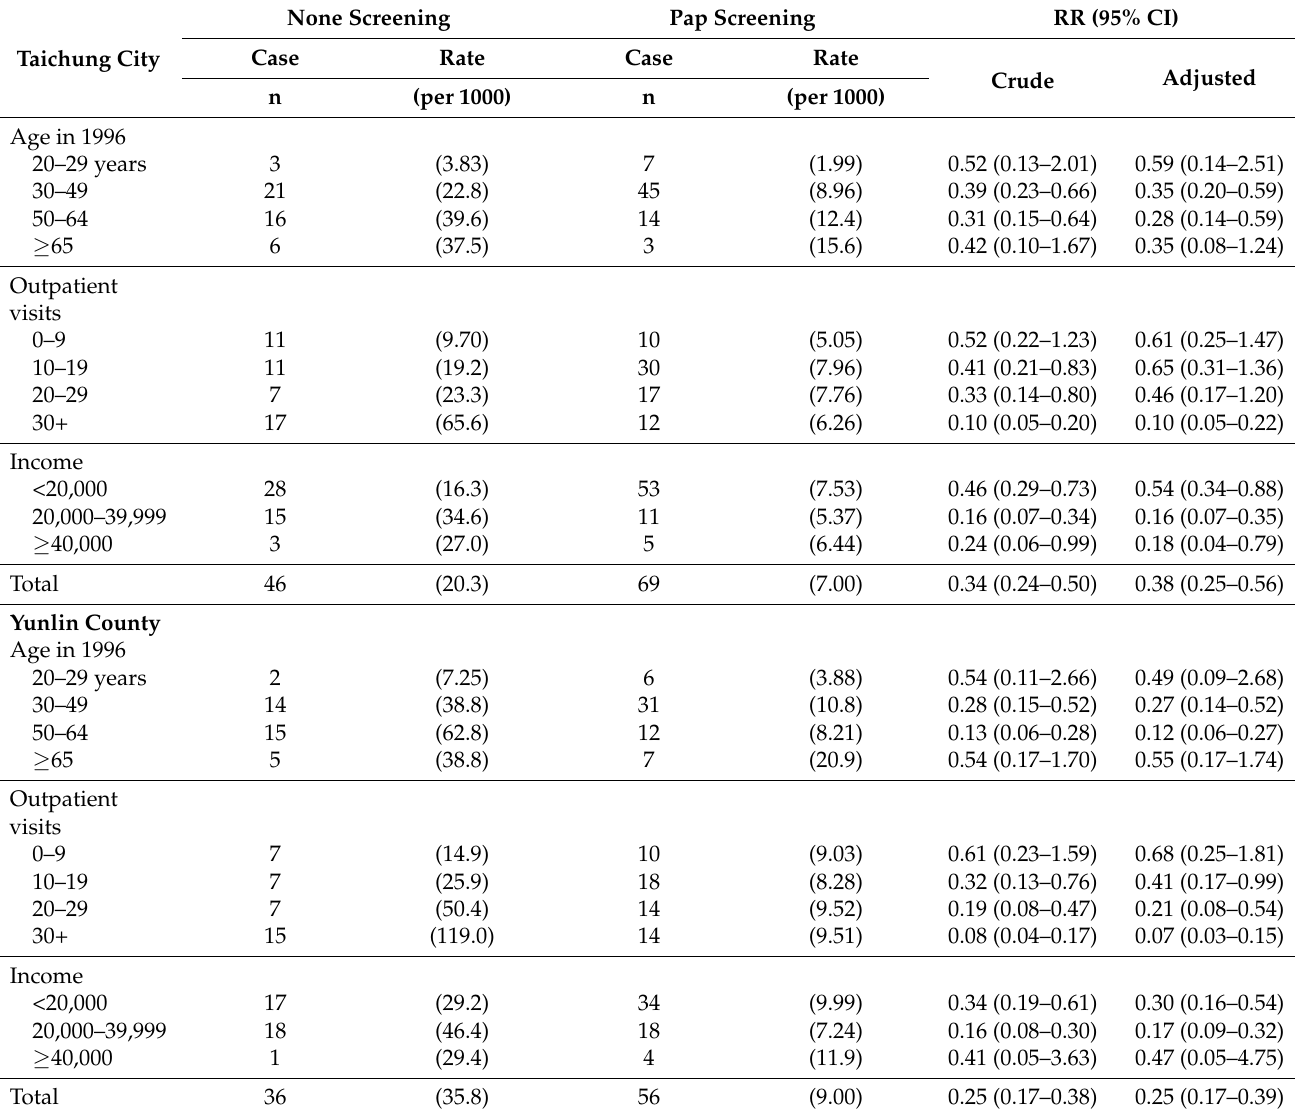
Table 2. Cervical cancer cases diagnosed and compared between every Pap smear screened and not screened by age, yearly outpatients visit, and income among women in Taichung city and Yunlin country, 1996–2013. None Screening Pap Taichung City